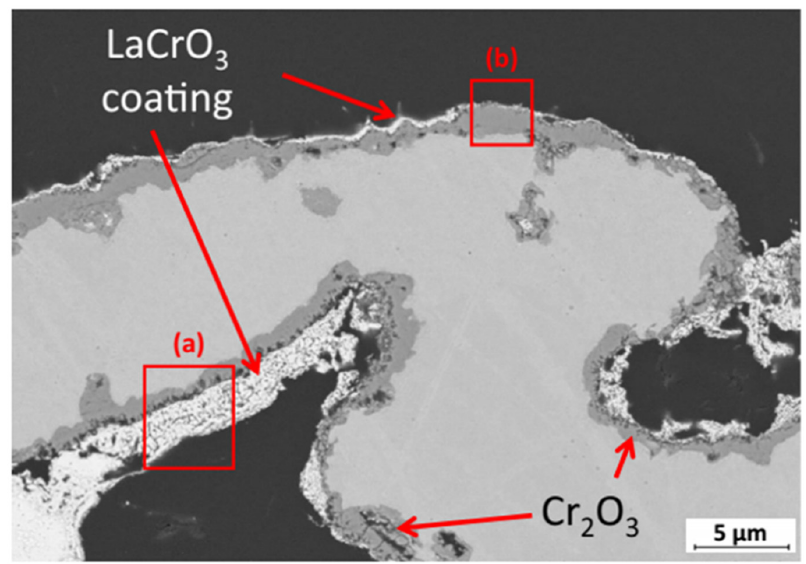
Figure 8. SEM image of porous ITM support after La acetate coating with the. indication of area ( a ) thick and area ( b ) thin LaCrO 3 -coating, reproduced with permission from Ref. [95].